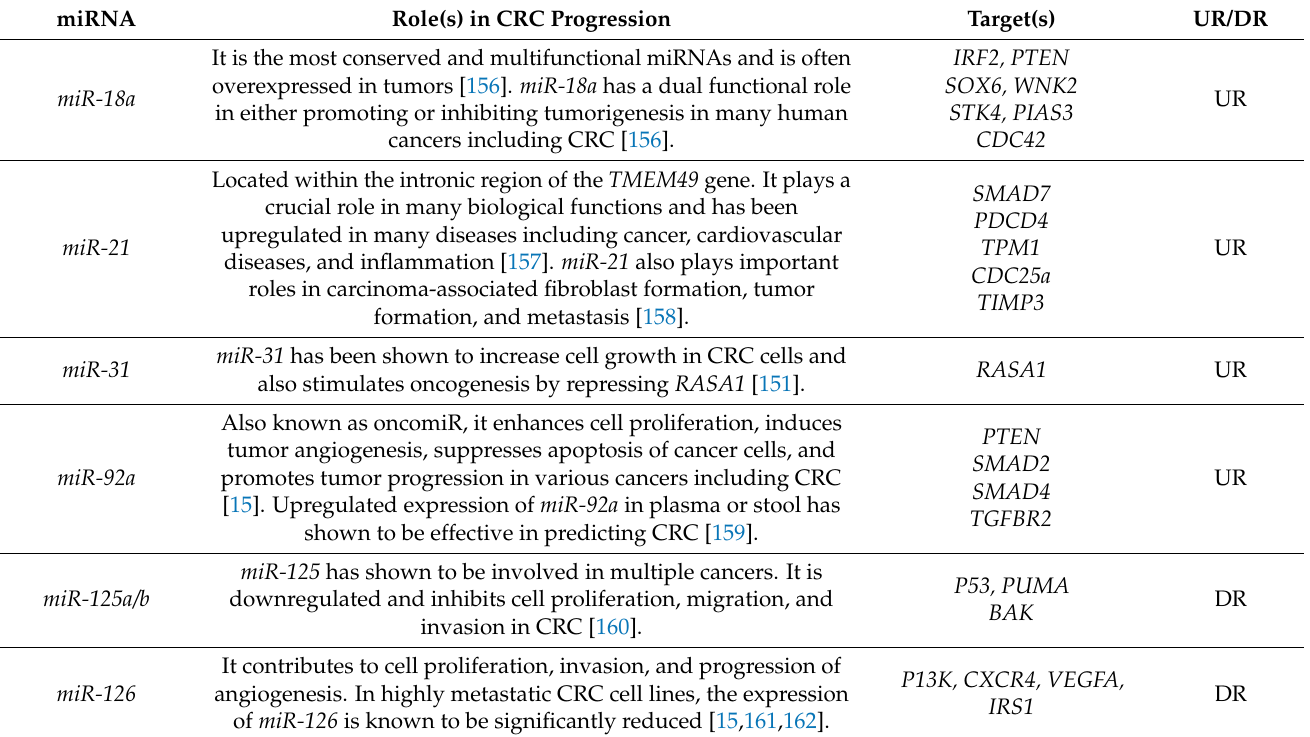
Table 2. Important miRNAs in CRC